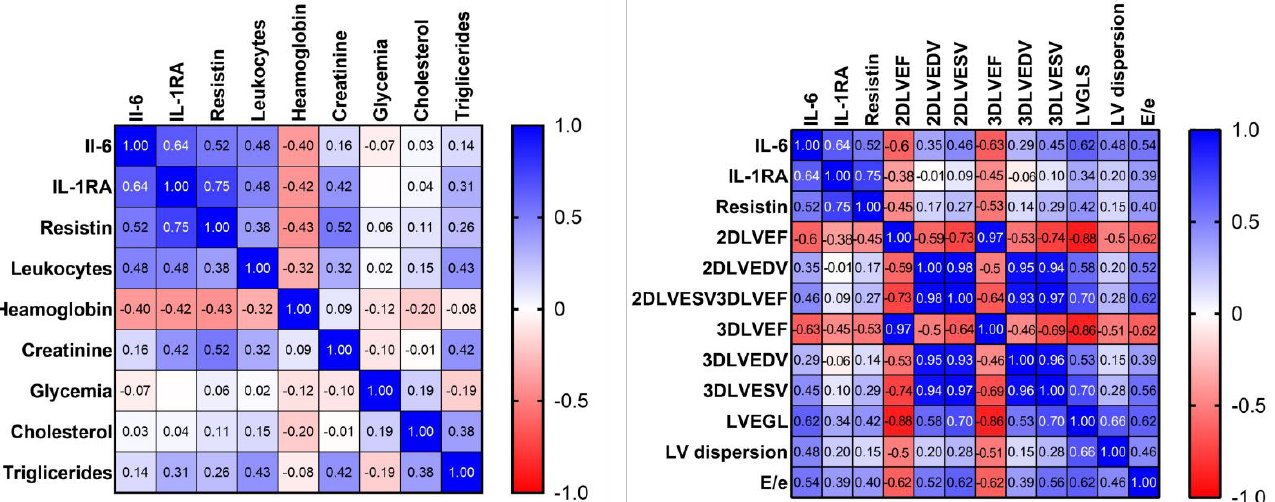
Figure 1. Correlation matrix: correlations between cytokines and biochemical and echocardio- graphic parameters.